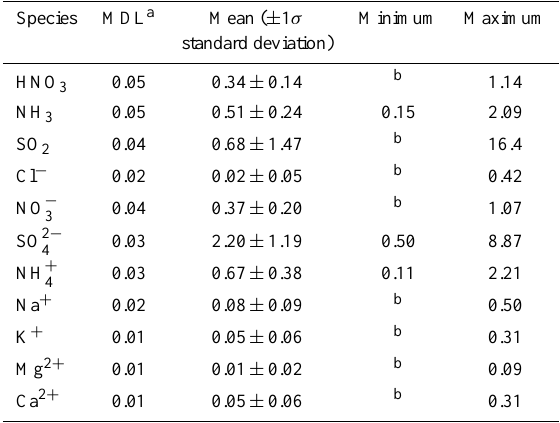
Table 1. Statistical summary of major gas and particle phase species measured by the MARGA. Concentrations (µgm − 3 ) of each species were collected from 1 June to 13 July 2013 ( n and were averaged over 1 hour of sample